Question: What direction does the quantity move in — increasing or decreasing?
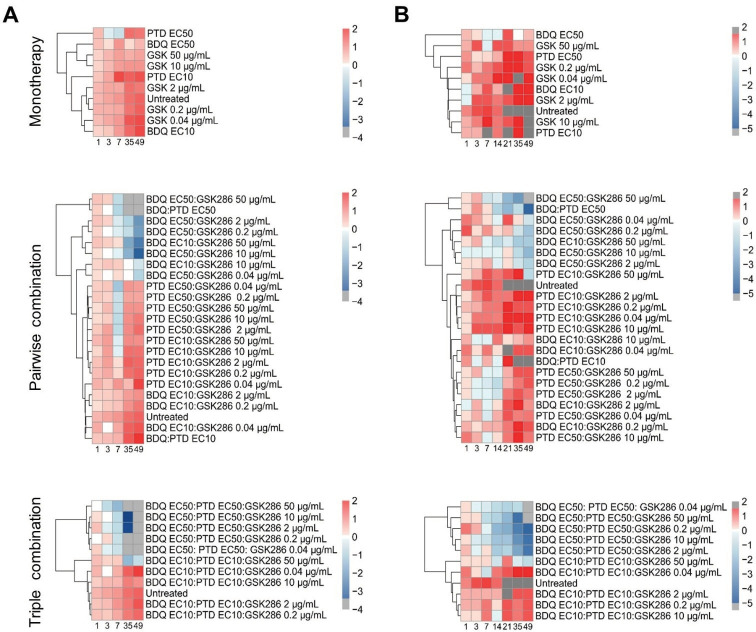
Answer: increasing